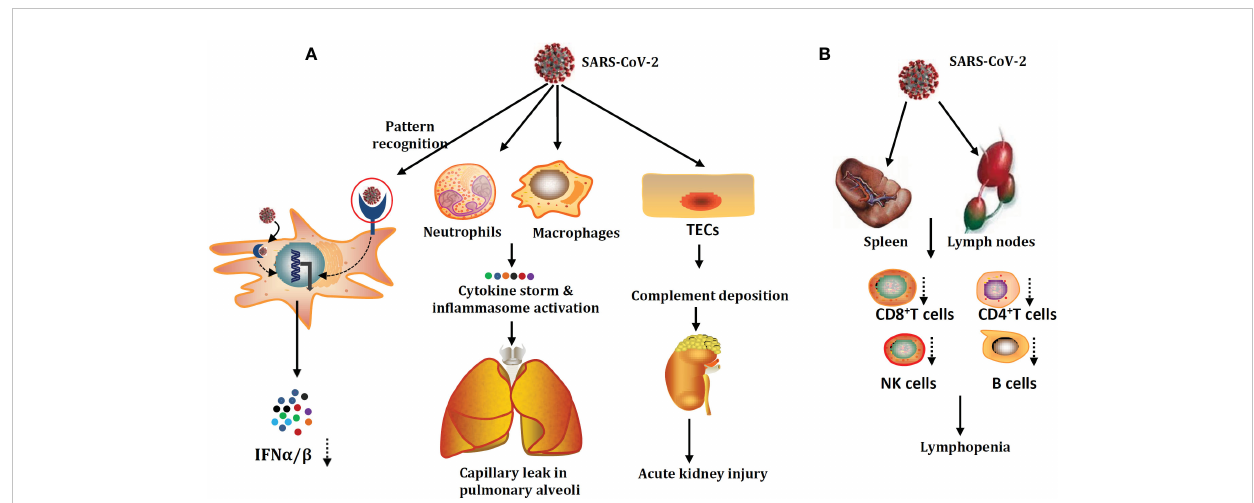
FIGURE 1 SARS-CoV-2 damage mechanisms on the innate immune system (A) and adaptive immune system (B) . SARS-CoV-2 could infect not only human type I alveolar cells but also the innate immune cells and tubular epithelial cells (TECs). SARS-CoV-2 infection could give rise to the accumulation of cytokine storms and hyperactivation of in fl ammasome. Apart from lymphopenia, the critical factor for poor prognosis in patients with severe COVID-19. Part of the acquired immune system damage, patients with severe COVID-19 are also accompanied by acute function exhaustion of T